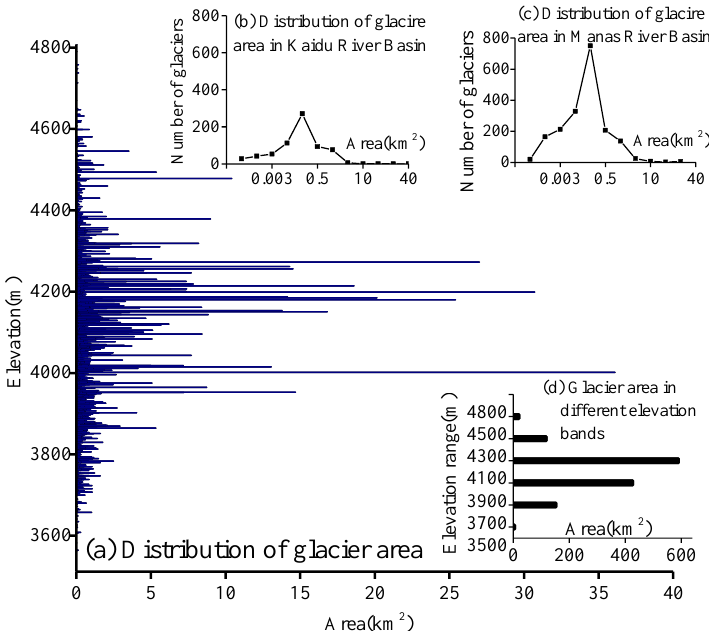
Figure 3. Elevation distribution characteristics of a single glacier area in both basins of central Tianshan Mountains. ( a ) Distribution of glacier area; ( b ) Distribution of glacier area in Kaidu River Basin; ( c ) Distribution of glacier area in Manas River Basin; ( d ) Glacier area in different elevation bands.